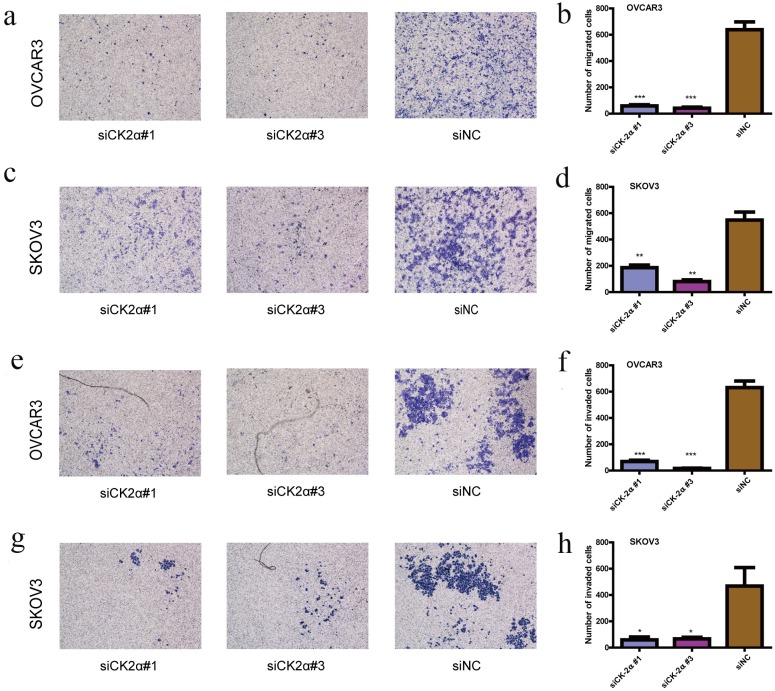
Suppression of EOC cell migration and invasion ability by CK2α silencing.(a-d) CK2α silencing by specific siRNAs inhibited the migration ability of OVCAR3 (a and b) and SKOV3 (c and d) cells in the Transwell migration assay. (e-h) CK2α silencing using specific siRNAs remarkably attenuated the invasion ability of OVCAR3 (e and f) and SKOV3 (g and h) cells in the Matrigel invasion assay. Data are presented as the mean ± SD of three independent experiments. P-values were obtained with the independent Student's t-test. *P < 0.05 vs. control; **P < 0.01 vs. the control; ***P < 0.001 vs. the control. Magnification: 200×.